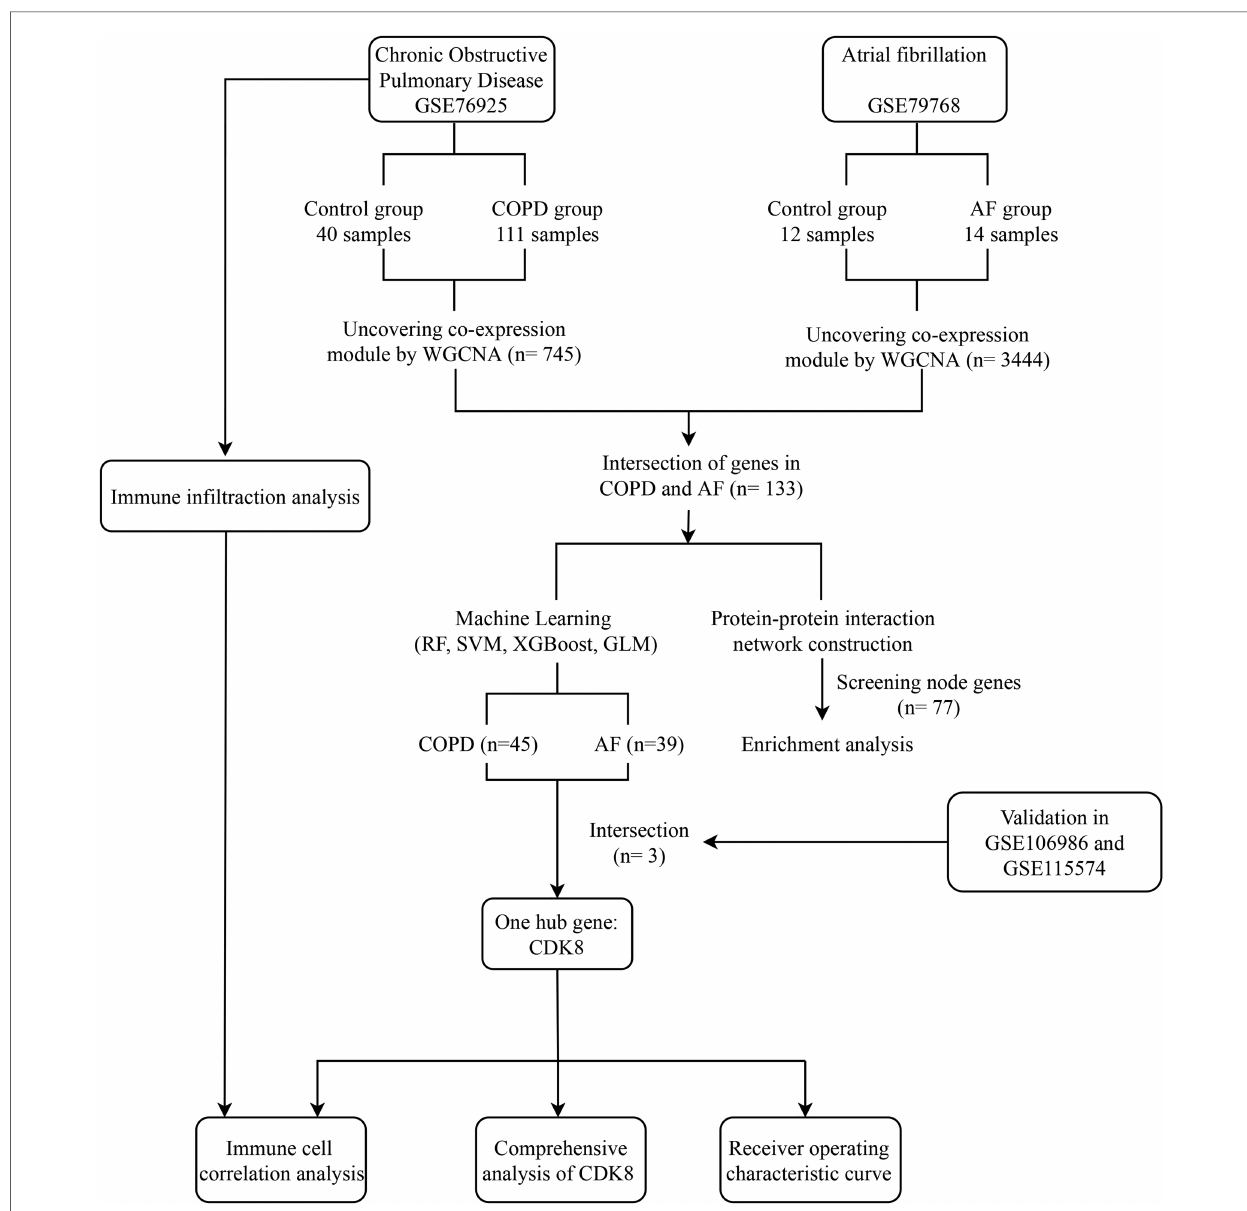
FIGURE 1 Study fl owchart. GSE, gene expression omnibus series; WGCNA, weighted gene co-expression network analysis; RF, Random forest support vector machine; SVM, support vector machine; XGBoost, extreme gradient boosting; GLM, generalized linear